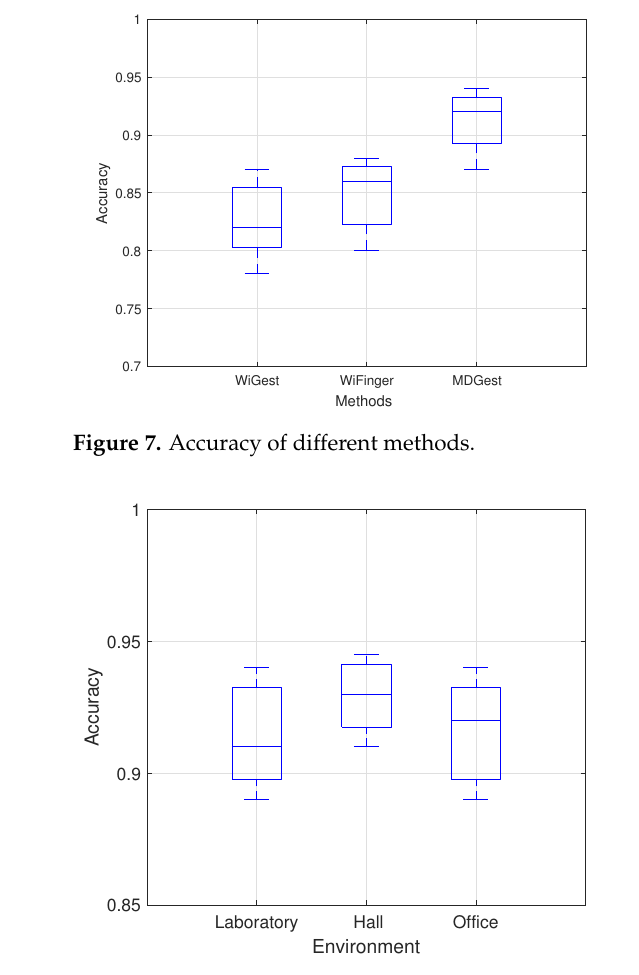
Figure 8. Accuracy of different environments. Table 1. The average recognition accuracy of each gesture in the three environments.